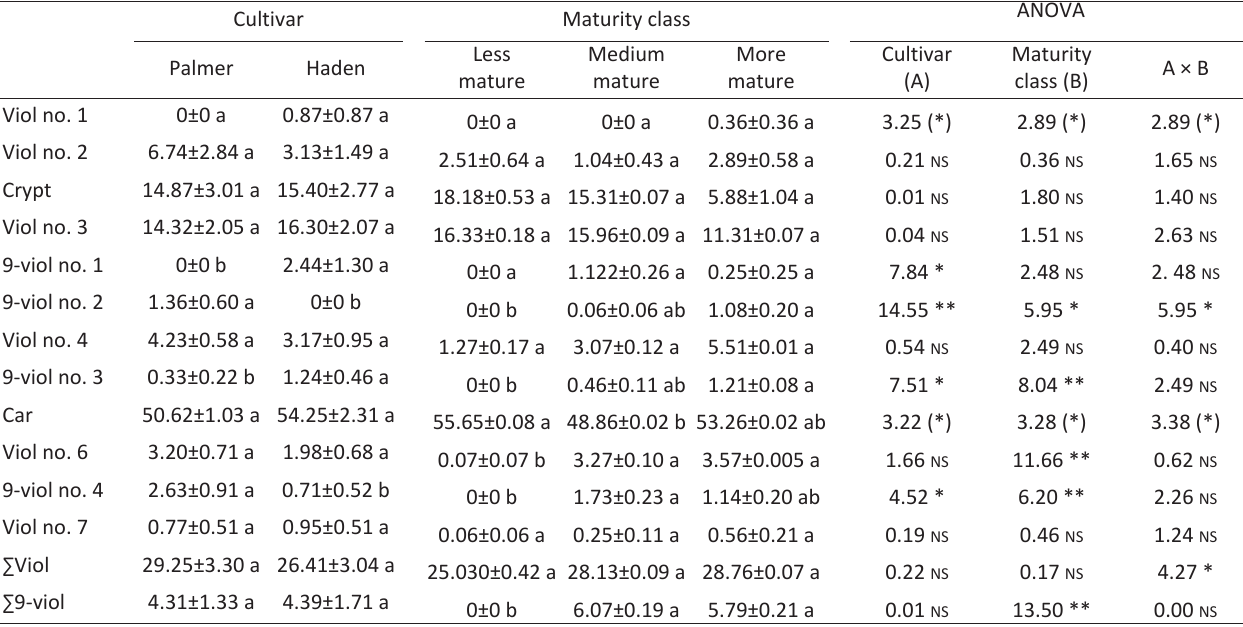
Table 5 - Carotenoid composition (percent to total carotenoids) of 'Palmer' and 'Haden' mangoes: influence of cultivar and of TRS matu-